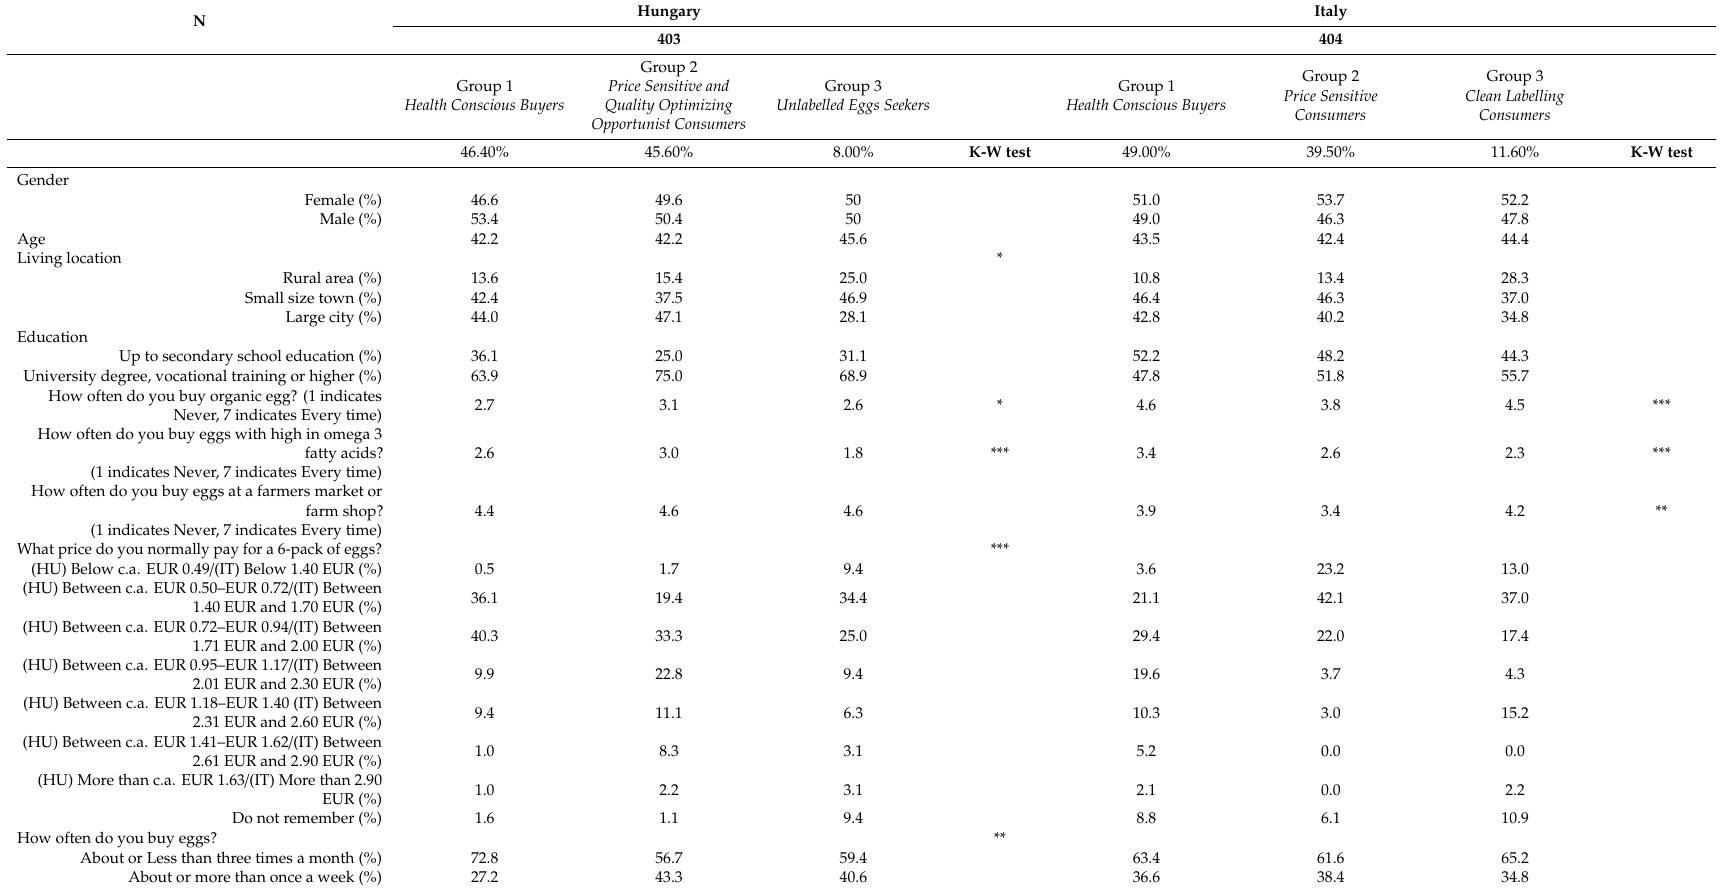
Table A2. Cross-country consumer segment profiles and the results of the Kruskal–Wallis